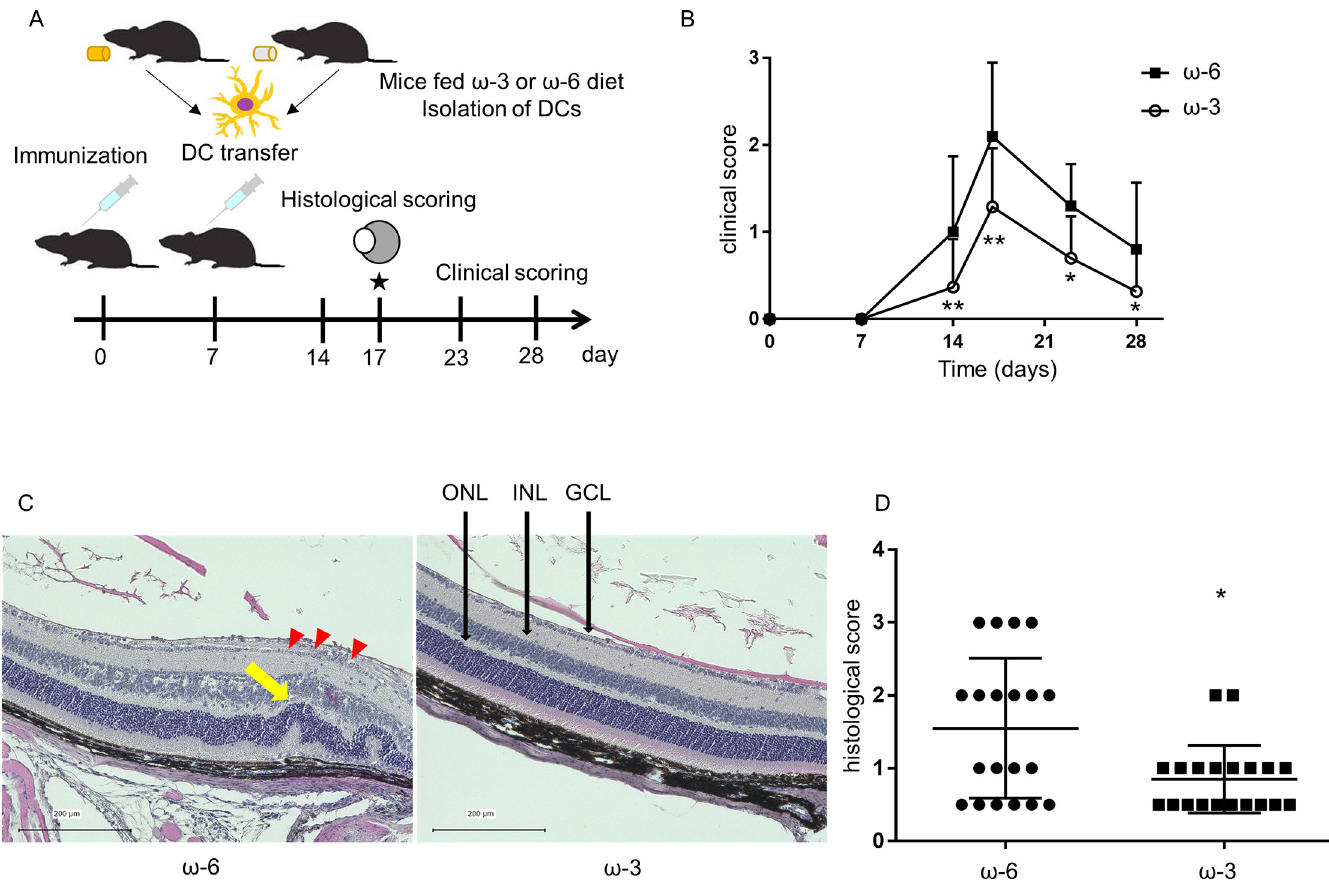
Fig 3. Clinical and histological scoring of EAU in model mice after adoptive transfer of DCs from ω -3 LCPUFA–fed mice. (A) Experimental scheme. At 7 days after disease induction, EAU mice underwent adoptive transfer of DCs (2.5 × 10 6 ) isolated and separately pooled from the spleen of mice fed a diet supplemented with ω -3 ( n = 5) or ω -6 ( n = 5) LCPUFAs. (B) The clinical score of EAU was determined 7, 14, 17, 23, and 28 days after disease induction. Data are means + SD for both eyes of five EAU mice per group. (C) Hematoxylin-eosin staining of retinal sections of EAU mice at 17 days after disease induction. Red arrowheads indicate inflammatory cells in the retina; yellow arrow indicates a retinal fold. GCL, ganglion cell layer; INL, inner nuclear layer; ONL, outer nuclear layer. Scale bars, 200 μ m. (D) Histological score for EAU determined from sections similar to those in (C). Data are shown for individual eyes of 10 EAU mice per group, and the mean ± SD values are also indicated. � P < 0.05, �� P < 0.01 versus the corresponding value for the ω -6 LCPUFA diet (Mann-Whitney U test).